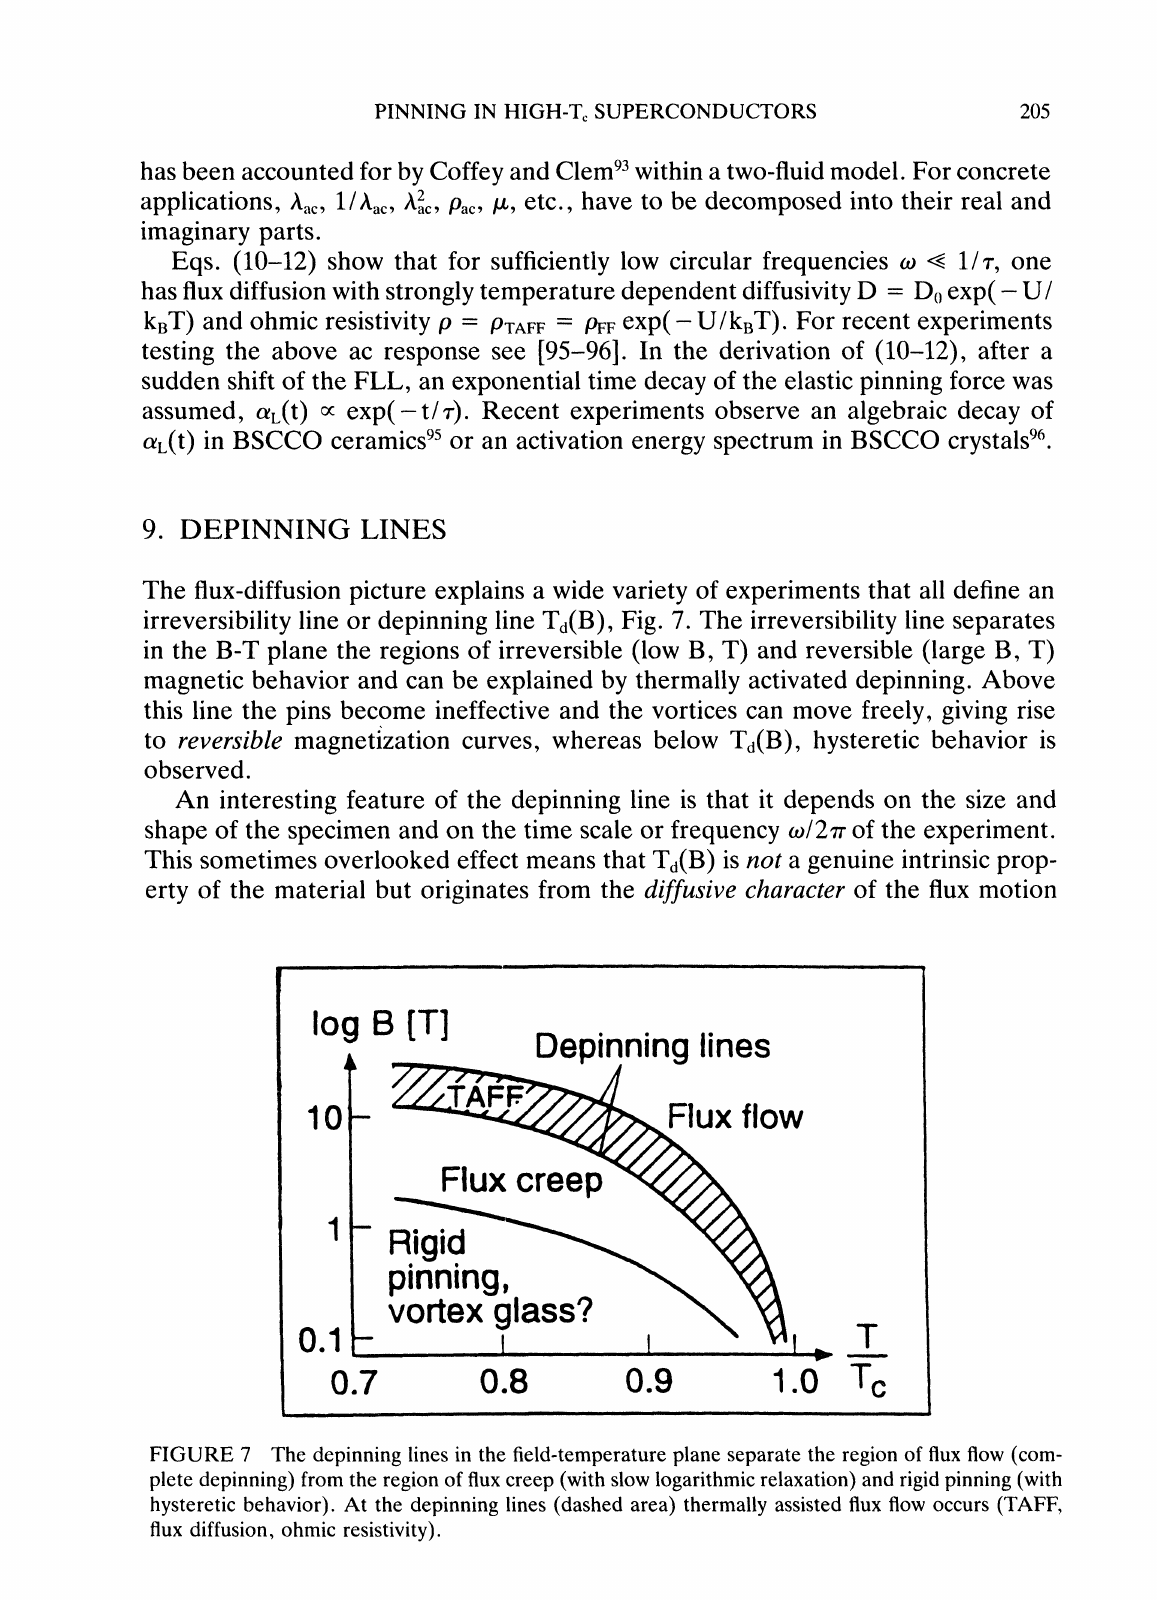
FIGURE 7 The depinning lines in the field-temperature plane separate the region of flux flow (com- plete depinning) from the region of flux creep (with slow logarithmic relaxation) and rigid pinning (with hysteretic behavior). At the depinning lines (dashed area) thermally assisted flux flow occurs (TAFF, flux diffusion, ohmic